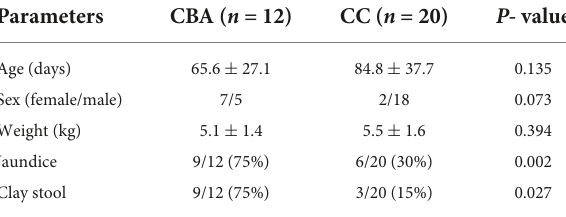
TABLE 1 Comparison of general gallbladder conditions between the CBA and CC